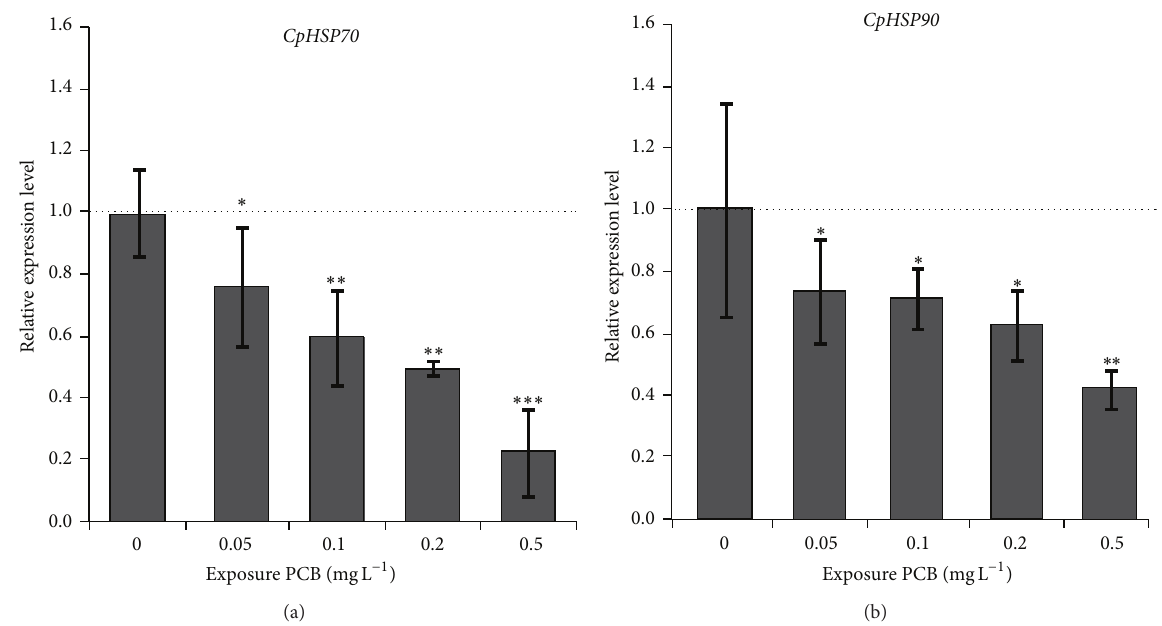
Figure 5: Gene expression profile of CpHSP70 (a) and CpHSP90 (b) after PCB treatment, respectively. Total RNA was extracted from C. polykrikoides at 24h after treatment with 0.05 mgL −1 , 0.1mg L −1 , 0.2 mg L −1 , and 0.5 mgL −1 of PCB, respectively. The 18S rRNA gene was used as the internal control to normalize the amount of templates in qRT-PCR. Results are given as the means of triplicate ± SD. The significant differences between the treated group and the control group are highlighted by one-way ANOVA; ∗∗ 𝑃 < 0.01 , ∗∗∗ 𝑃 < 0.001 . gradually till high dose (8.0 mg L −1 of CuSO 4 ), whereas